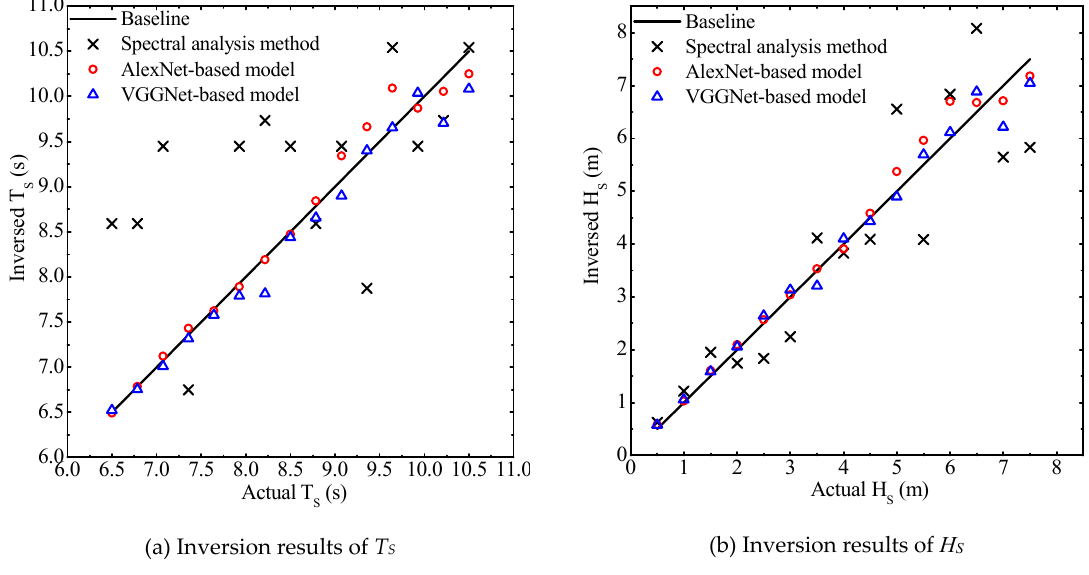
Figure 5. Inversion results by the spectral analysis and CNN-based methods.